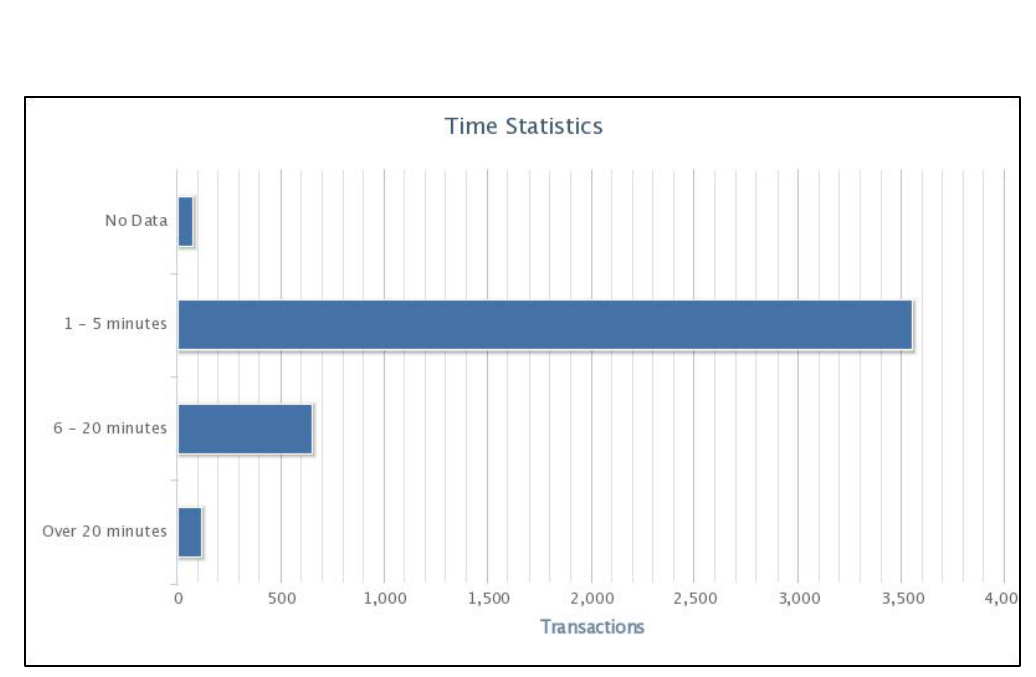
Question time ranges as automatically generated by the Reference Analytics